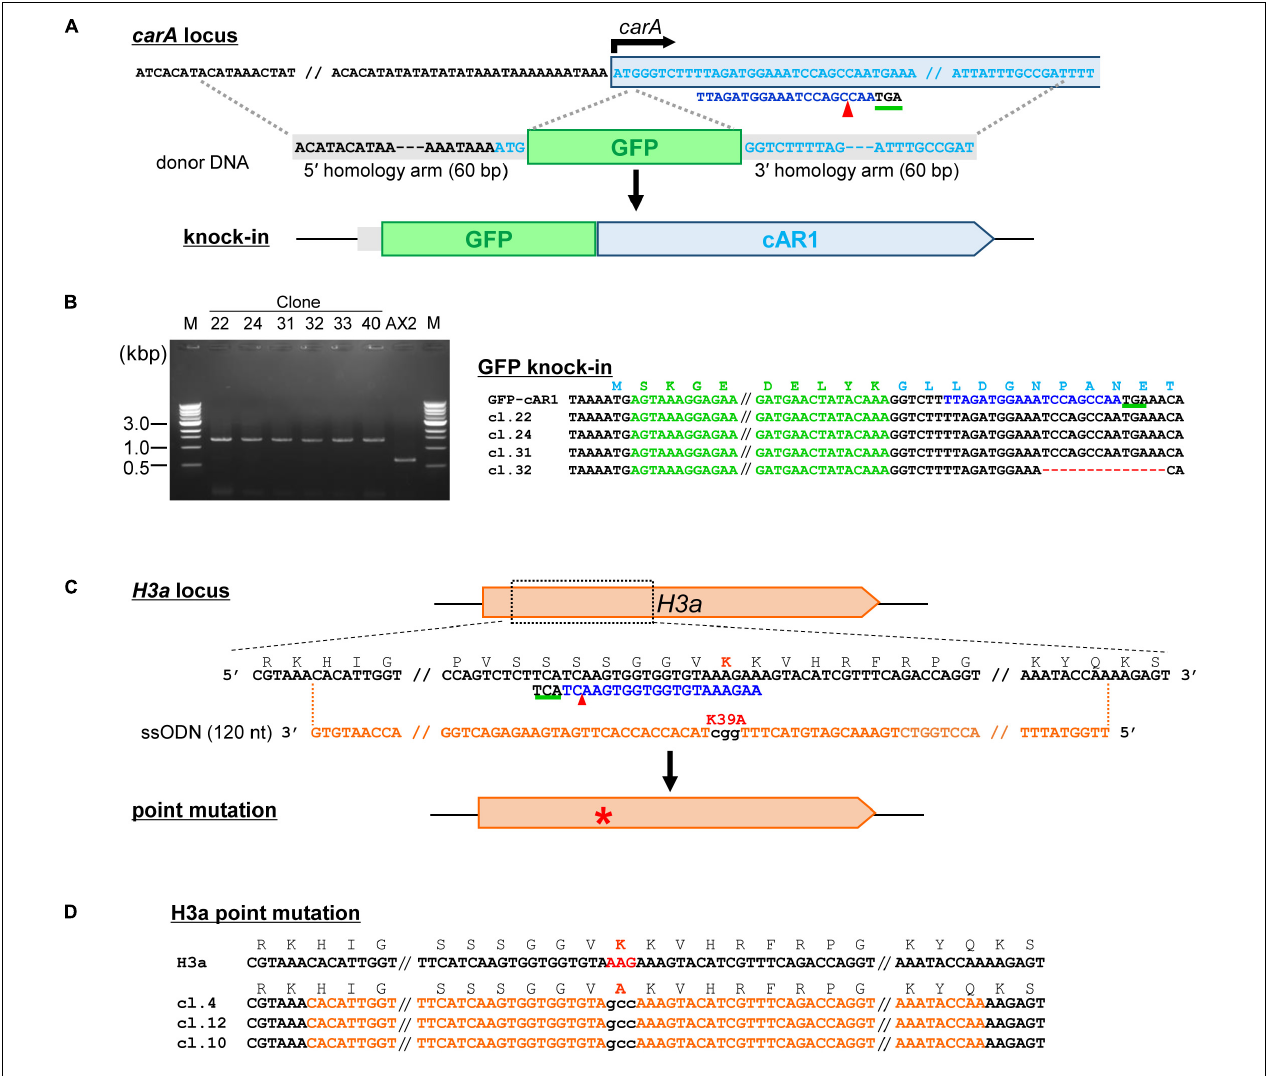
FIGURE 5 | Tagging a protein of interest and precise nucleotide substitutions mediated by CRISPR/Cas9. (A) Schematic diagram of tag knock-in of cAR1 locus. Target sequences are in light blue and the PAM sequence is underlined in green. The donor fragment was amplified by PCR using GFP primers flanked with 60-nt homology arms. (B) Mutation–detective PCR using primers flanking the knock-in site. The PCR fragments different in size were identified. (C) Schematic diagram of precise nucleotide substitutions of H3aK39A. (D) Sequencing resutls of mutants for knock-in precise nucleotide substitutions. The target sequence is in blue and mutations are in red. Numbers in parentheses indicate the number of modified